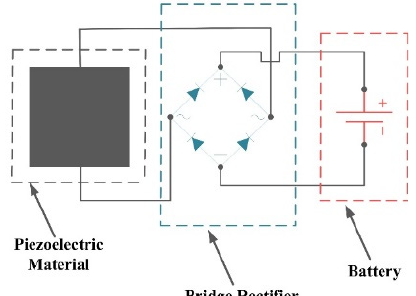
Figure 15. Circuit of the energy harvester to store the generated electricity in a battery.